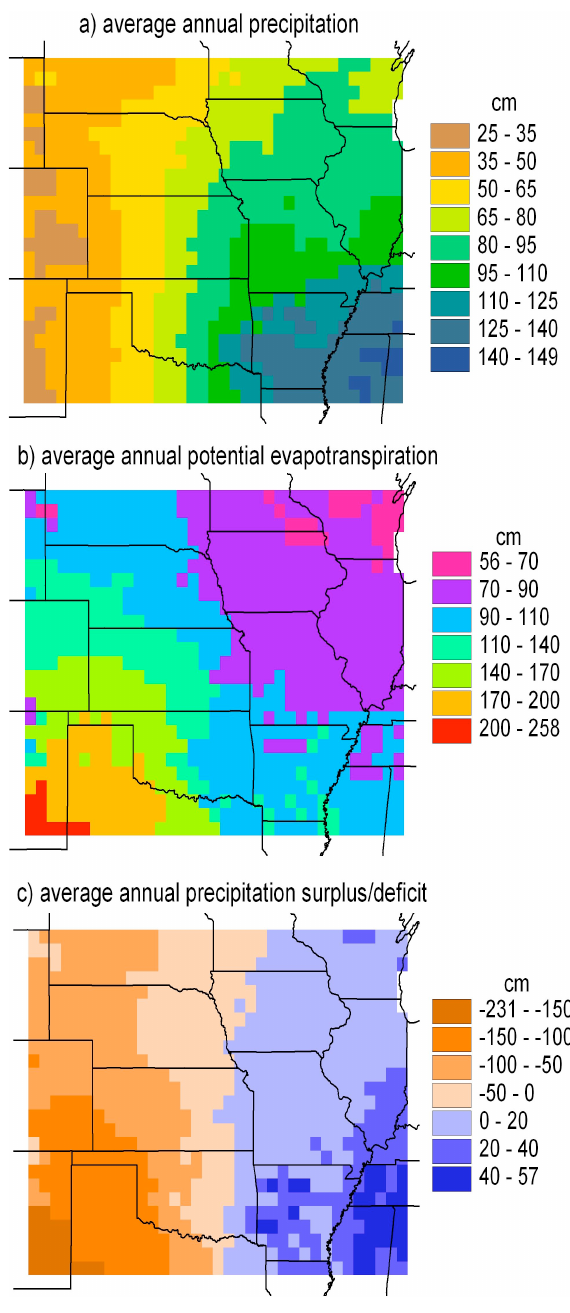
Fig. 1. (a) Average annual precipitation from the VEMAP/PRISM database, (b) average annual potential evapotranspiration calculated using model-maximized LAI, and (c) the difference (1951–1980).